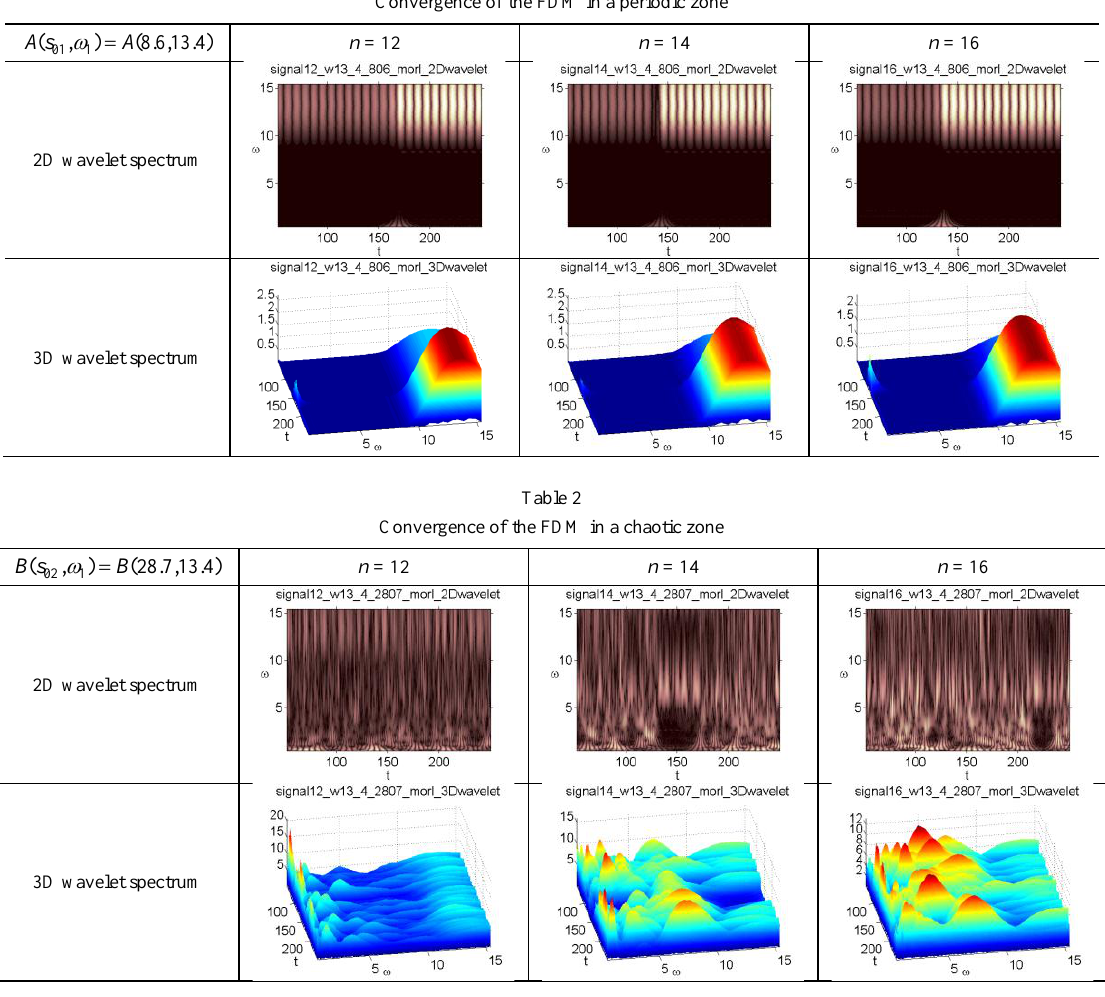
Convergence of the FDM in a chaotic